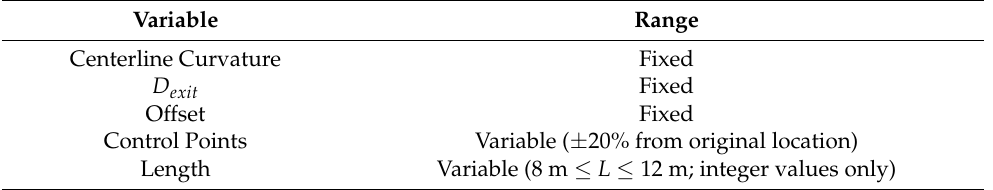
Figure 7. Variables and terminology defining the S-duct geometry (green: varied during optimization; red: fixed). Table 1. Optimization